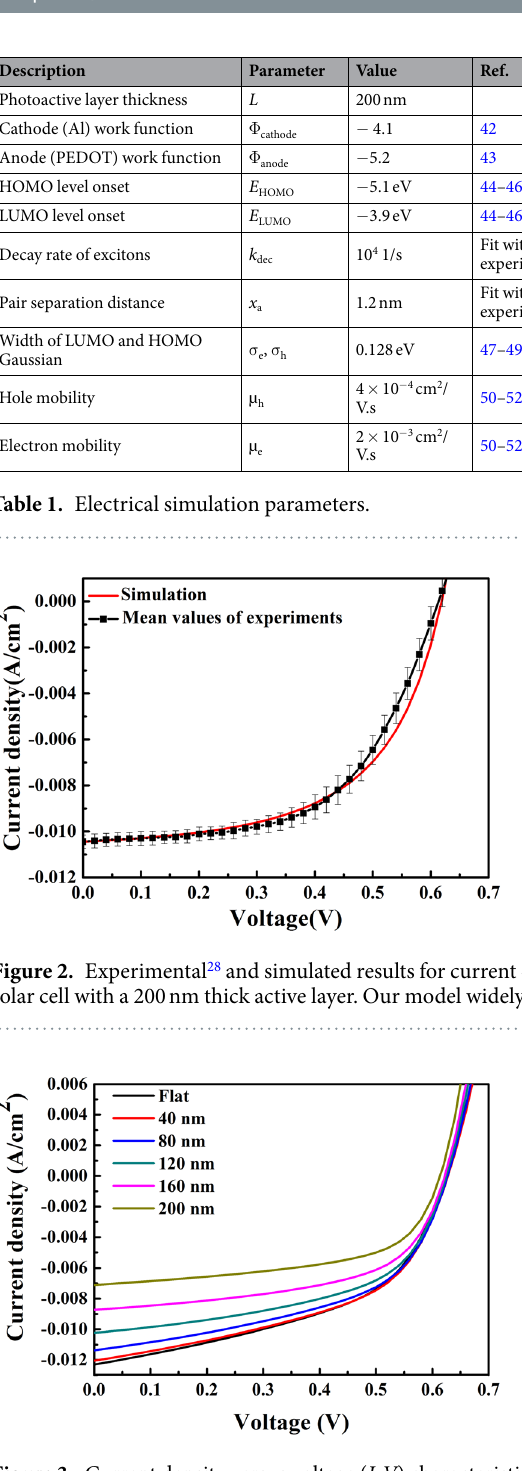
Figure 3. Current density versus voltage ( J-V ) characteristic of the flat OSC, compared to the devices with back contact grating of varying height. For an increased pillar height, J sc (in magnitude), V oc and PCE decrease. On the other hand, the FF increases with increasing nano-structure height. (Higher Jsc compared to Fig. 2 is due to larger active layer thickness (280